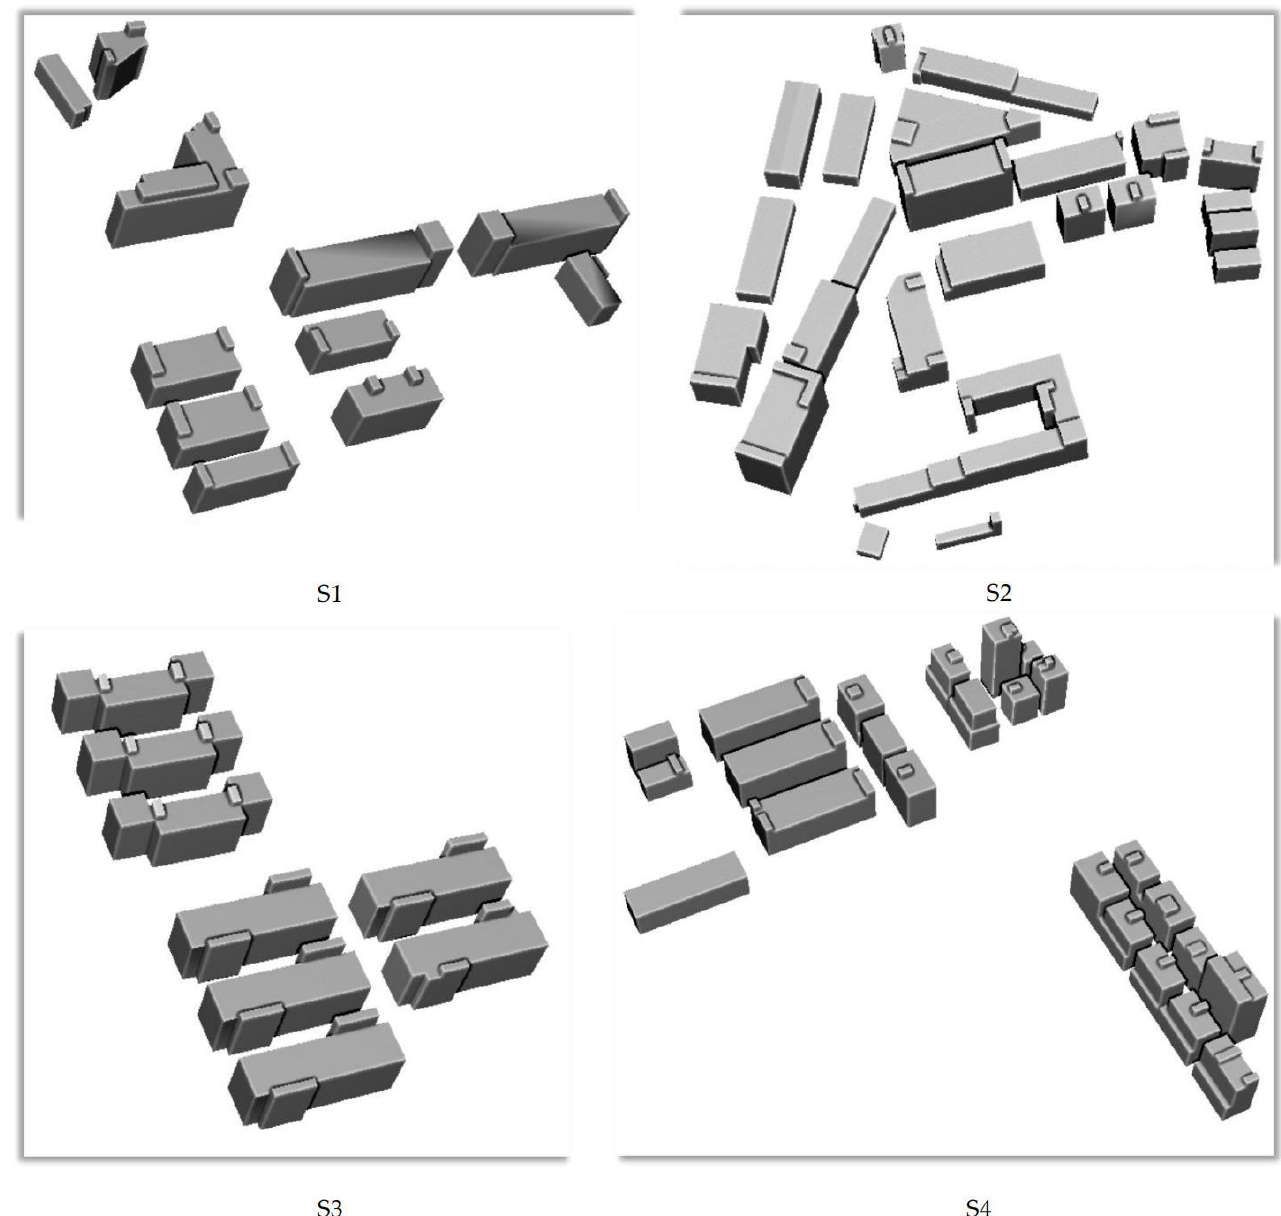
Figure 10. Reconstruction results of all buildings in Shenzhen.